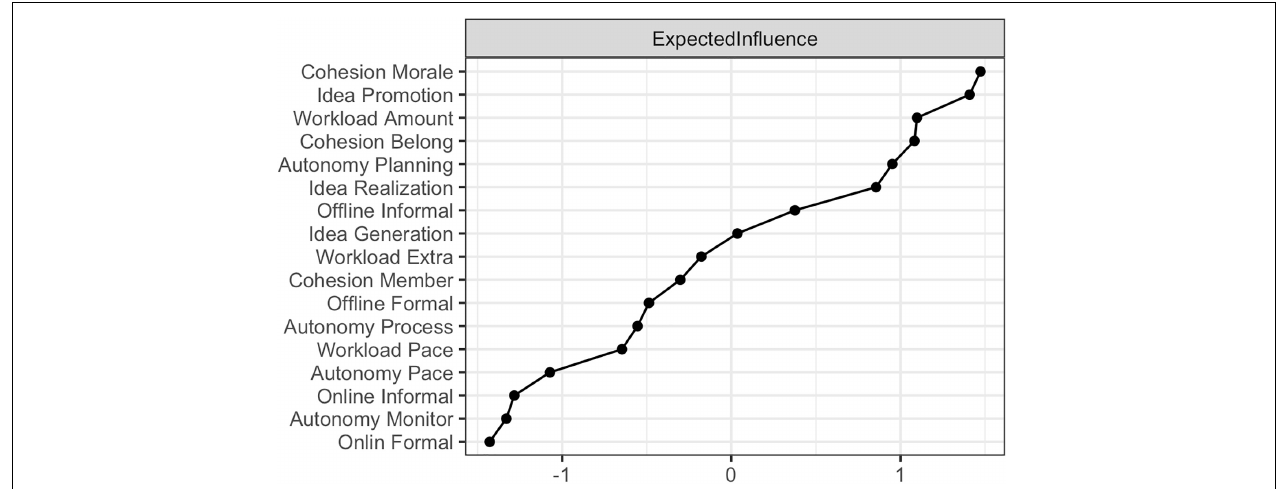
FIGURE 2 | Expected influence centrality of the employee perceptions, attitudes and behaviors related to innovative work behavior. Standardized expected influence centrality of the attitudes and behaviors related to